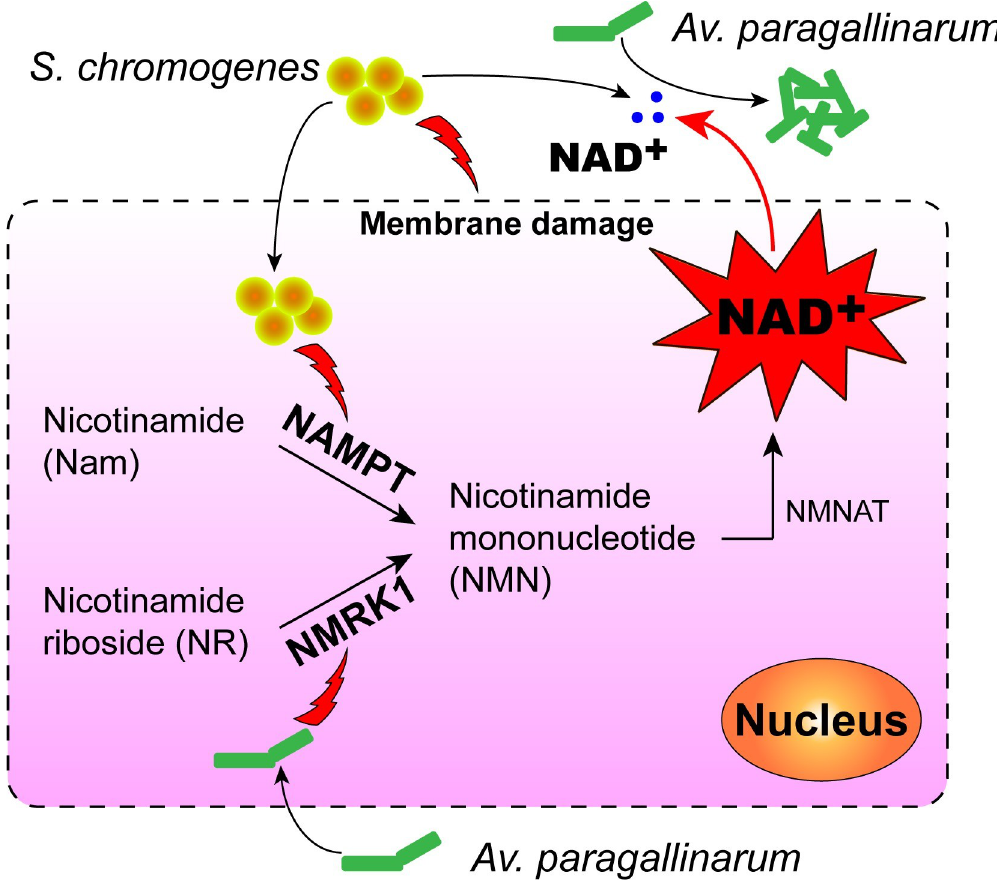
Fig 7. Resident bacteria promote the replication of Av . paragallinarum . Resident bacteria such as S . chromogenes enhance NAD + biosynthesis and release by host cells in the respiratory tract. Consequently, the increased NAD + level in the extracellular environment accelerates the replication of Av . paragallinarum